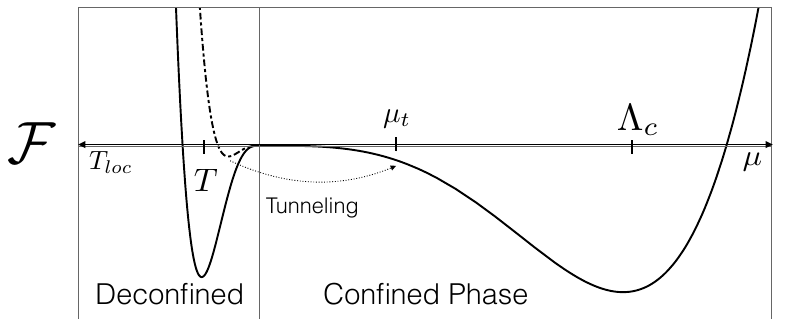
Figure 2 . Free energy along the tunneling path described in the main text. In the decon(cid:12)ned phase (left side) it is a function of the local temperature T loc , while in the con(cid:12)ned phase it is a function of (cid:22) . The two phases are identi(cid:12)ed at the point T loc = 0 = (cid:22) . On the left, we show the free energy pro(cid:12)le for T . T c (solid line) and for T T c (dot-dashed), to show in particular that (cid:28) a much larger region in (cid:22) space becomes energetically accessible as temperature decreases. On the right, we show the dilaton